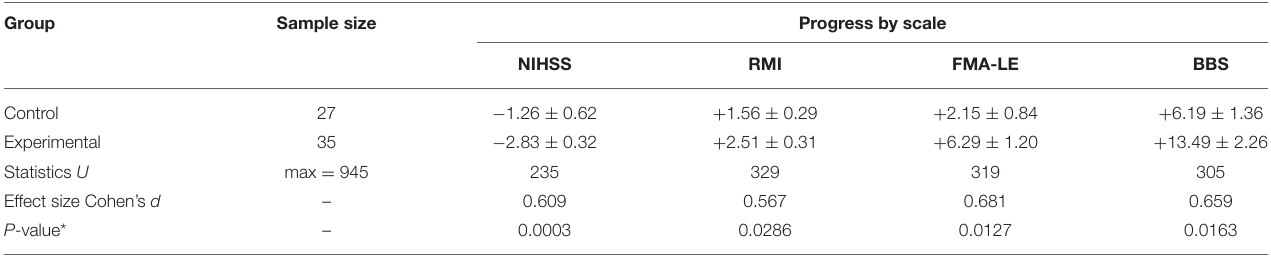
TABLE 2 | Progress of the rehabilitation; values presented as mean ± SD. Group Sample